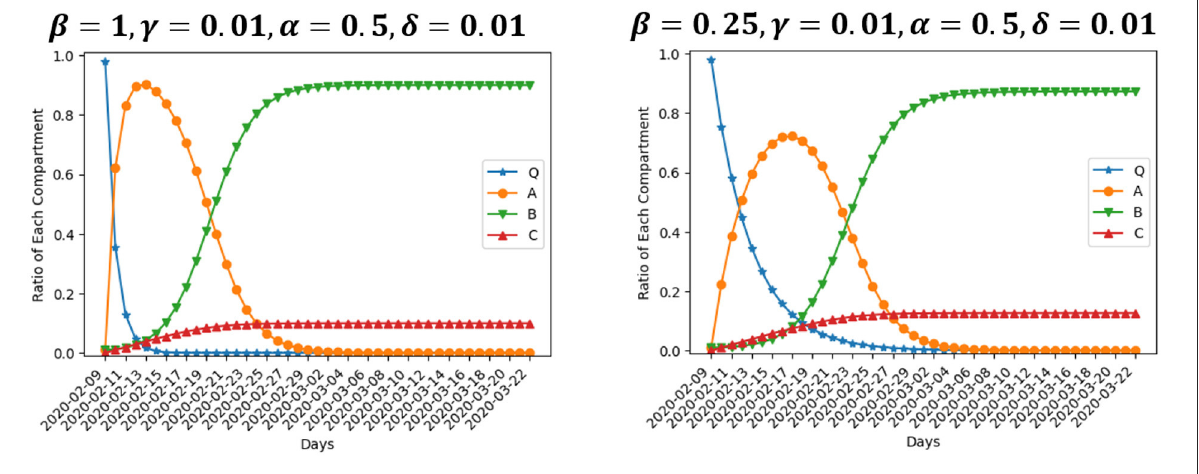
FIGURE4 Simulation using different values of β